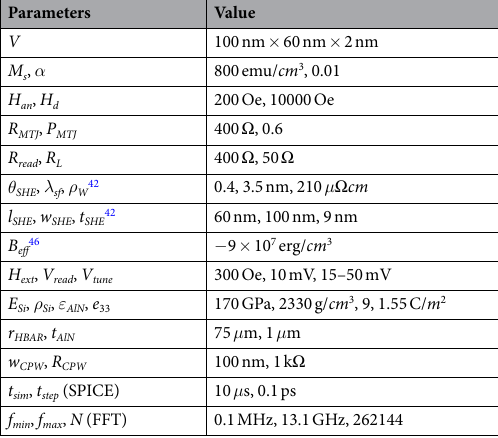
Table 2. Device and material parameters used in all